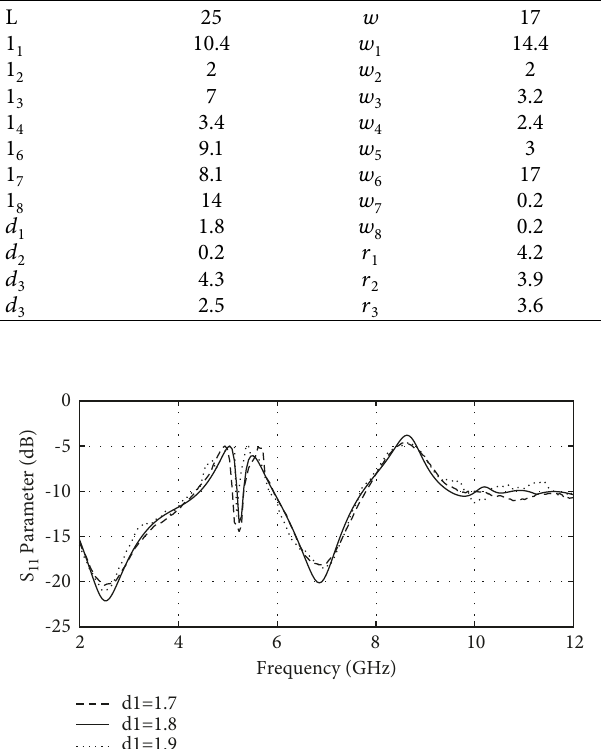
Figure 2: Different values of distance d